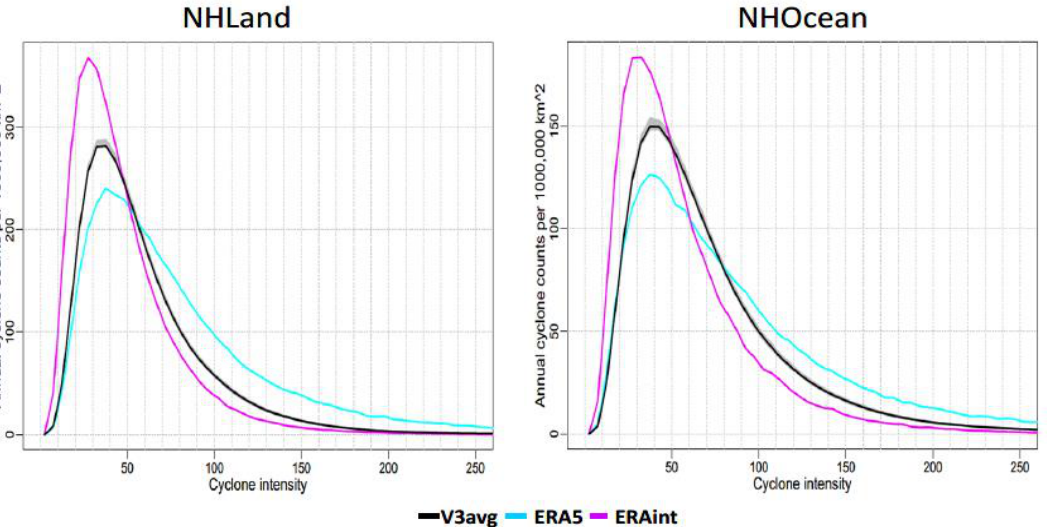
Figure 2. Histograms of annual cyclone counts (per 10 6 km 2 ) as a function of cyclone intensity (10 − 5 hPa km − 2 ) over the northern extratropical land ( left ) and ocean ( right ) for the period 1979–2015. The bin size of the cyclone intensity is 5 units. The ensemble standard deviation (grey shading) is also given for